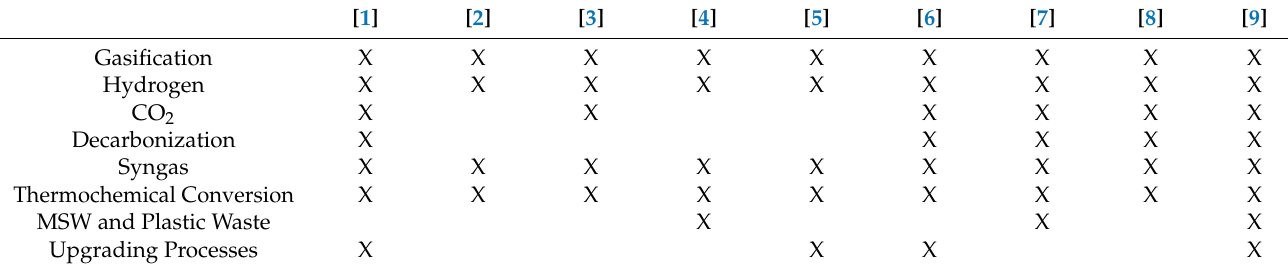
Table 1. Correlation matrix of the selected